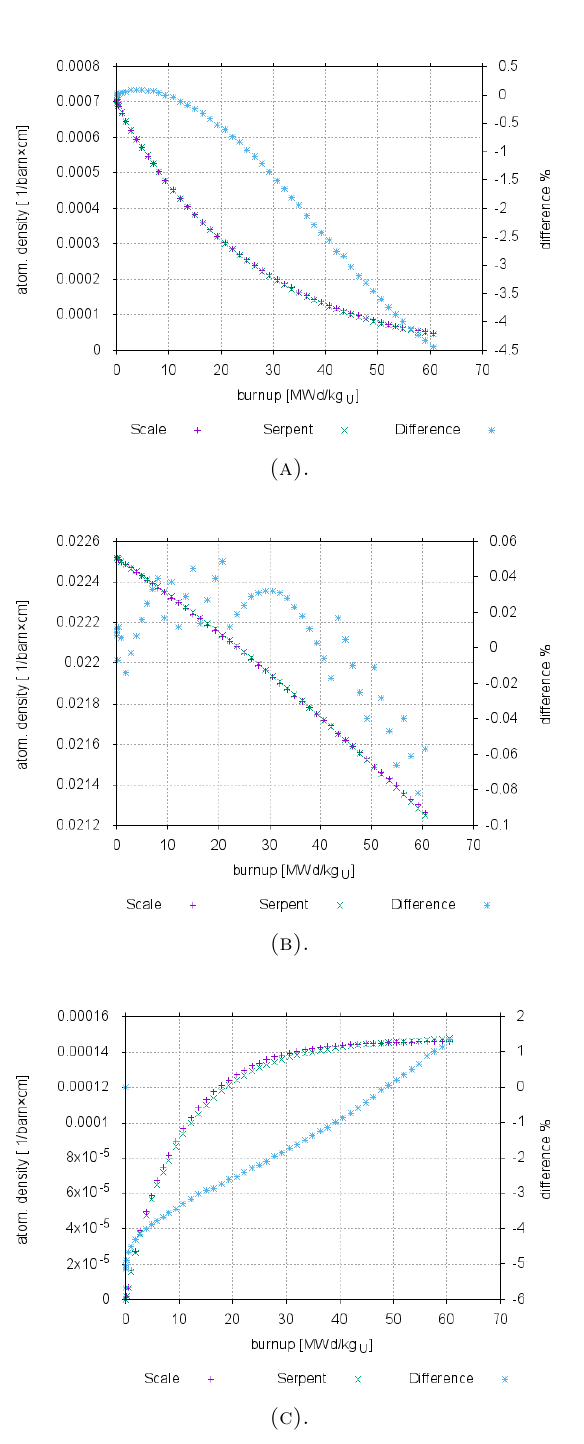
Figure 8. Isotope concentration of (a) 235 U, (b) 238 U and (c) 239 Pu for both codes and difference between